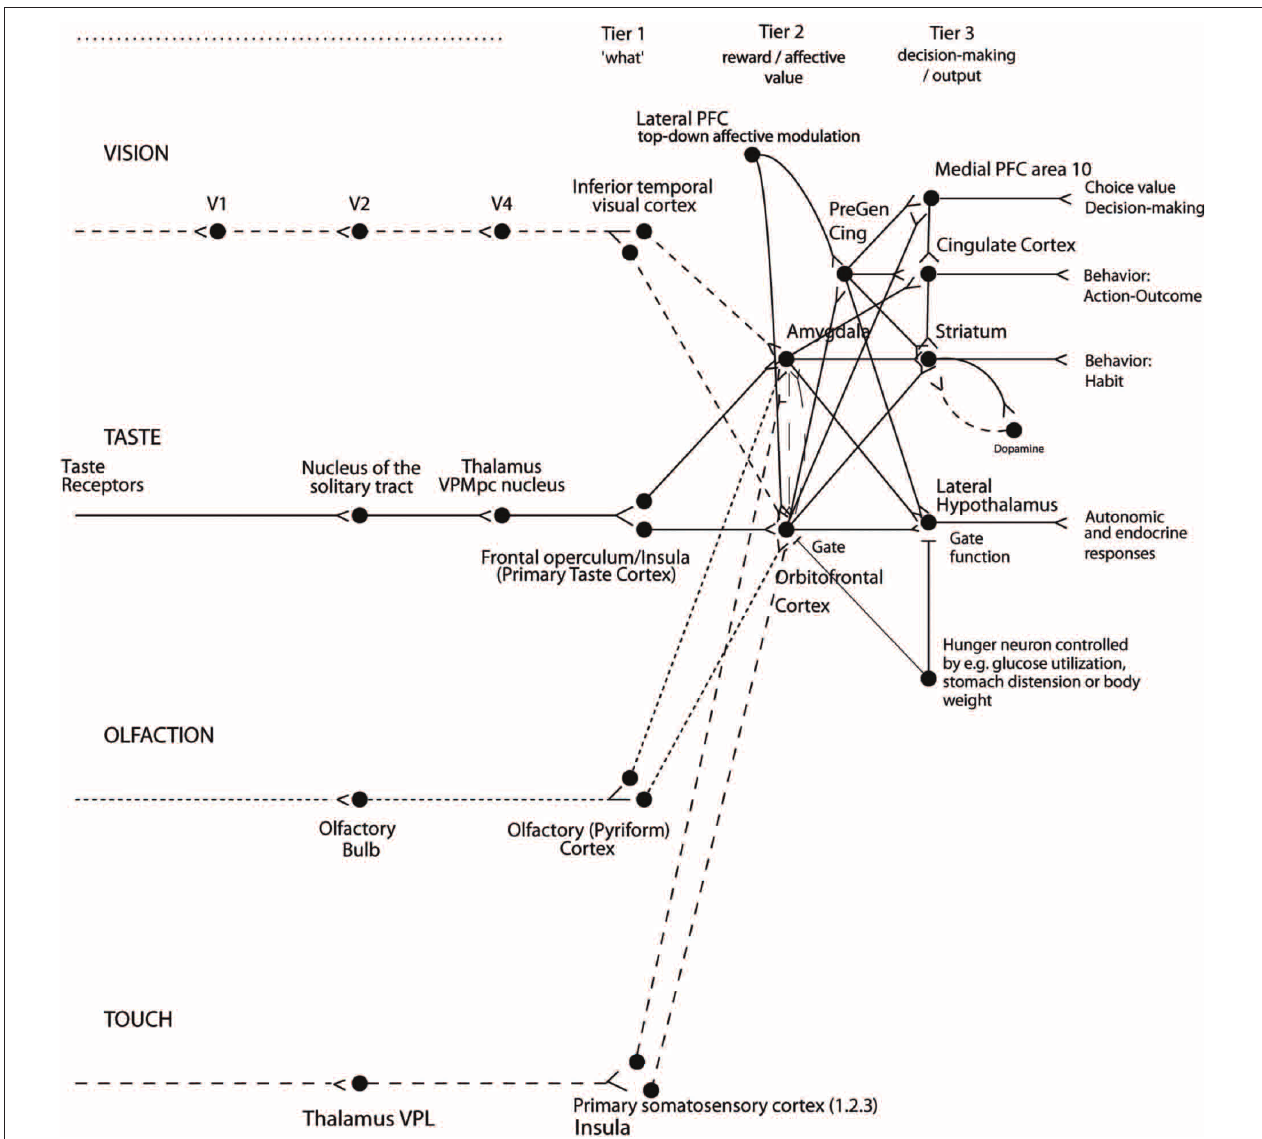
FIGURE 2 | Organization of cortical processing for computing value (in Tier 2) and making value-based decisions (in Tier 3) and interfacing to action systems. The Tier 1 brain regions up to and including the column headed by the inferior temporal visual cortex compute and represent neuronally “what” stimulus/object is present, but not its reward or affective value. Tier 2 represents by its neuronal firing the reward or affective value, and includes the orbitofrontal cortex, amygdala, and anterior including pregenual cingulate cortex. Tier 3 is involved in choices based on reward value (in particular VMPFC area 10), and in different types of output to behavior. The secondary taste cortex, and the secondary olfactory cortex, are within the orbitofrontal cortex. V1—primary visual cortex. V4—visual cortical area V4. PreGen Cing—pregenual